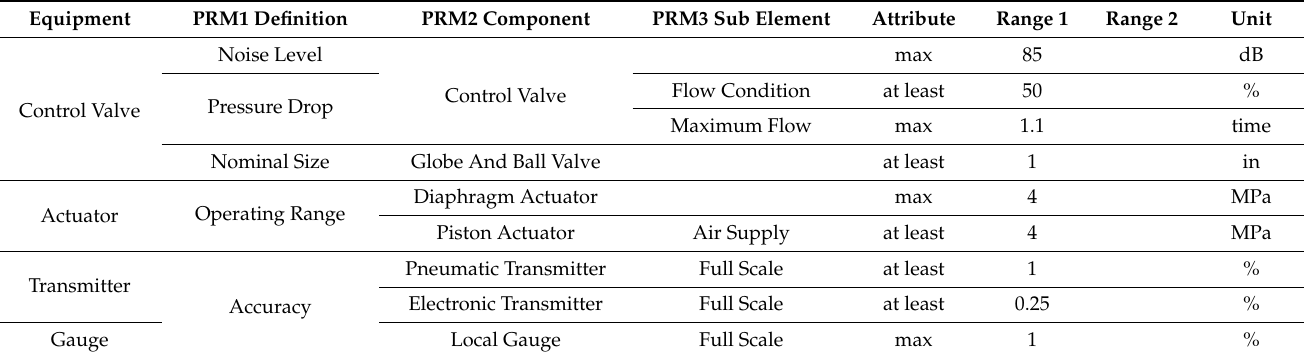
Table 4. SDP of 4 pieces of equipment in the instrument process.